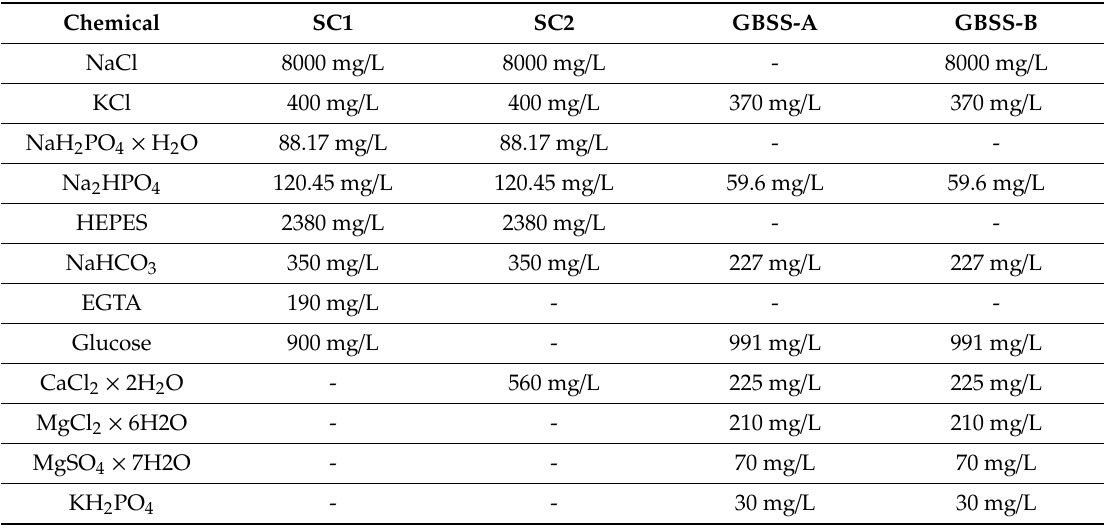
Table 4. Composition of bu ff ers used for primary liver sinusoid endothelial cell